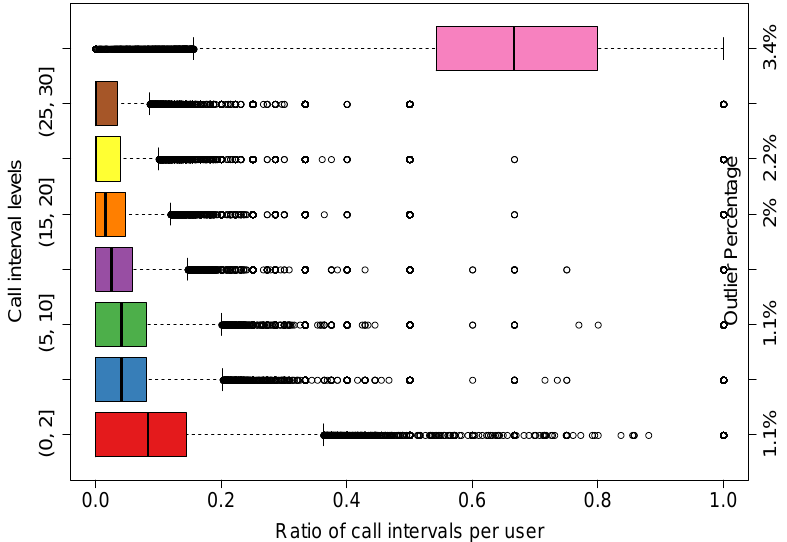
Figure 23. The ratio of calls with intervals at different